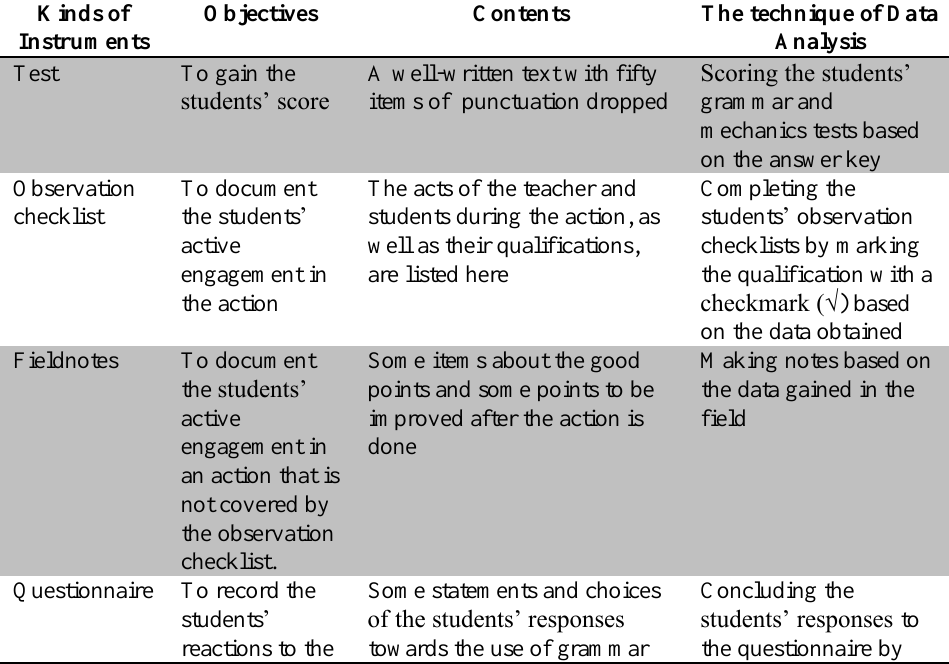
Table 1. Kinds of Instruments Used in the Present Study Kinds